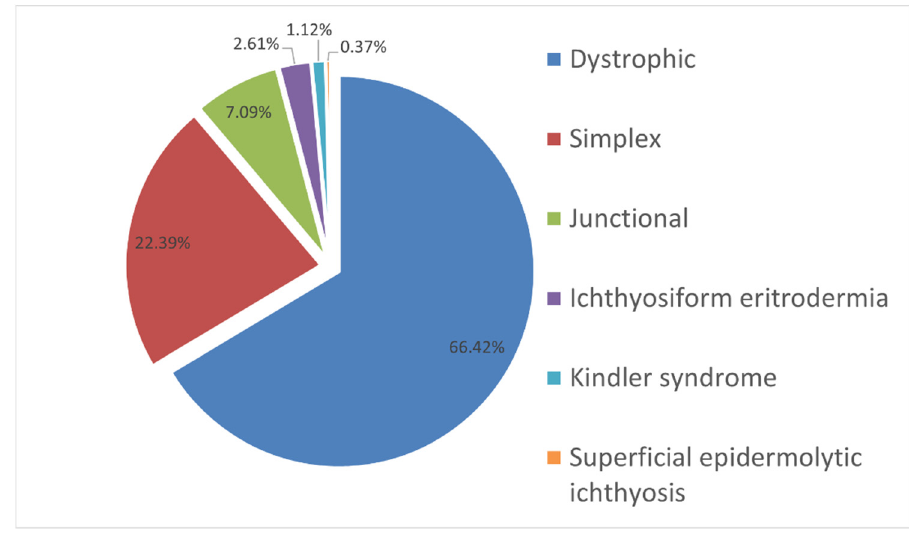
Figure 1. The incidence expressed as percentage cases of different dermatosis forms with the EB symptom complex in examined Russian children.